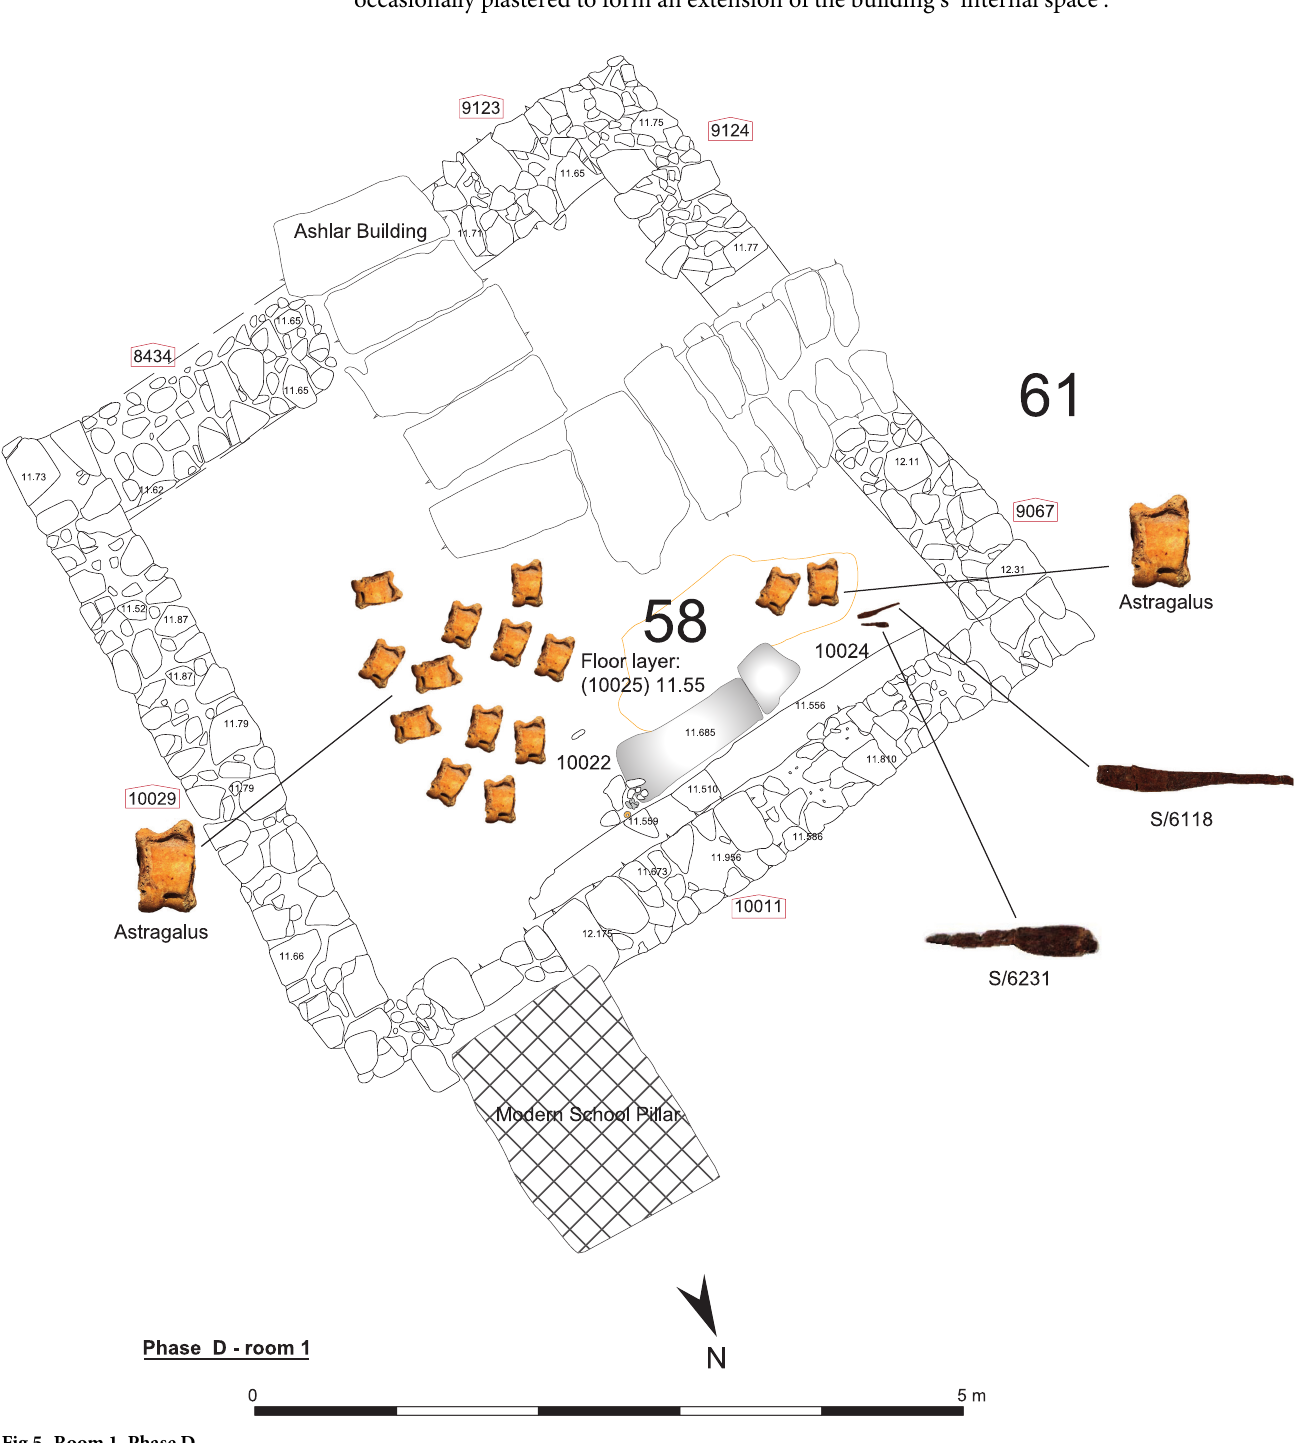
Fig 5. Room 1, Phase